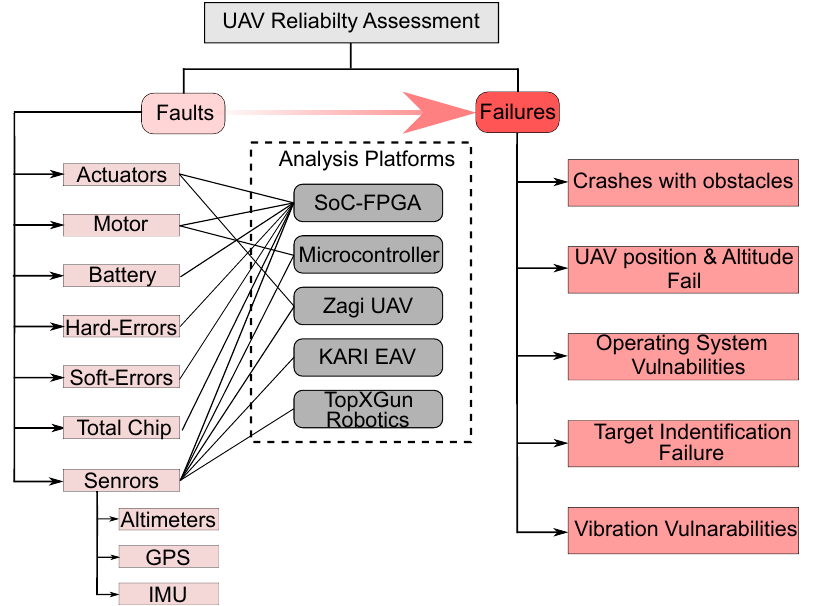
Figure 3. Fault and failure modes analysis